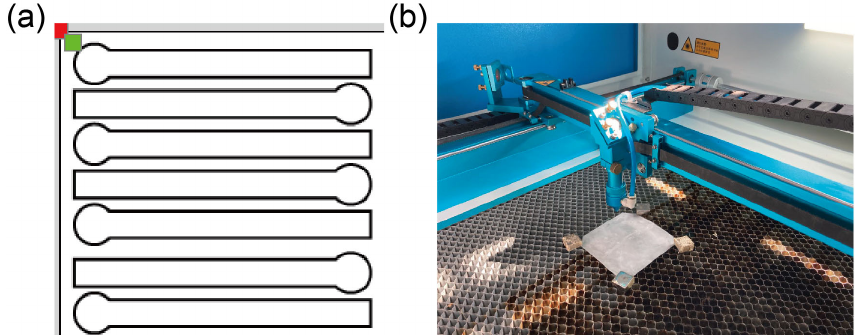
Figure A1. Cutting pattern design ( a ) and set up ( b ) of the laser cutter.